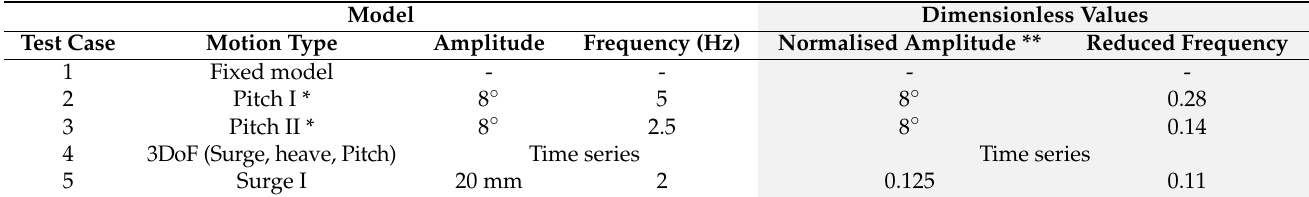
Table 1. Test matrix for the imposed motions on the porous disc